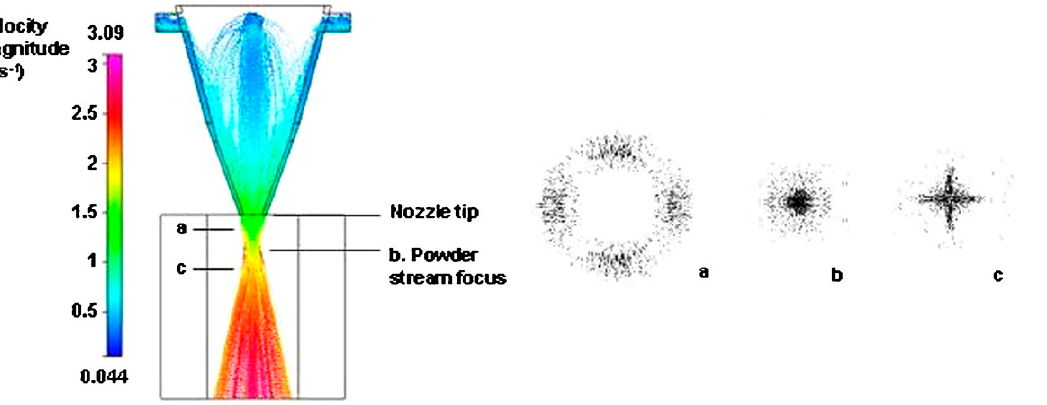
Figure 5. Modeled particles distribution and velocity obtained at different planes: (plane a) above the flow focal point, (plane b) at the flow focal point, and (plane c) below the flow focal point (reproduced with permission from [54]; Copyright © 2011 Taylor & Francis).